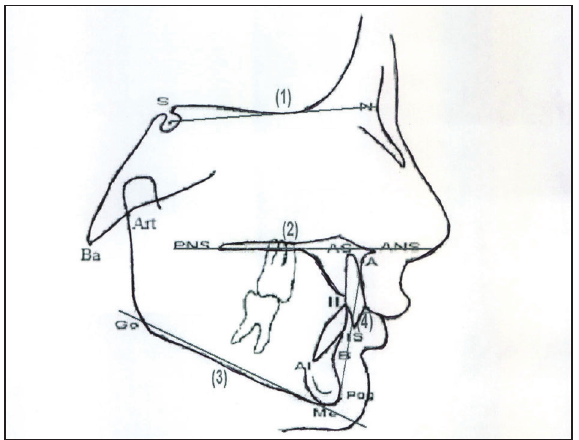
Figure 2. Reference planes:(1), SN plane; (2), Maxillary plane; (3), Mandibular plane; (4), A-Pog line.